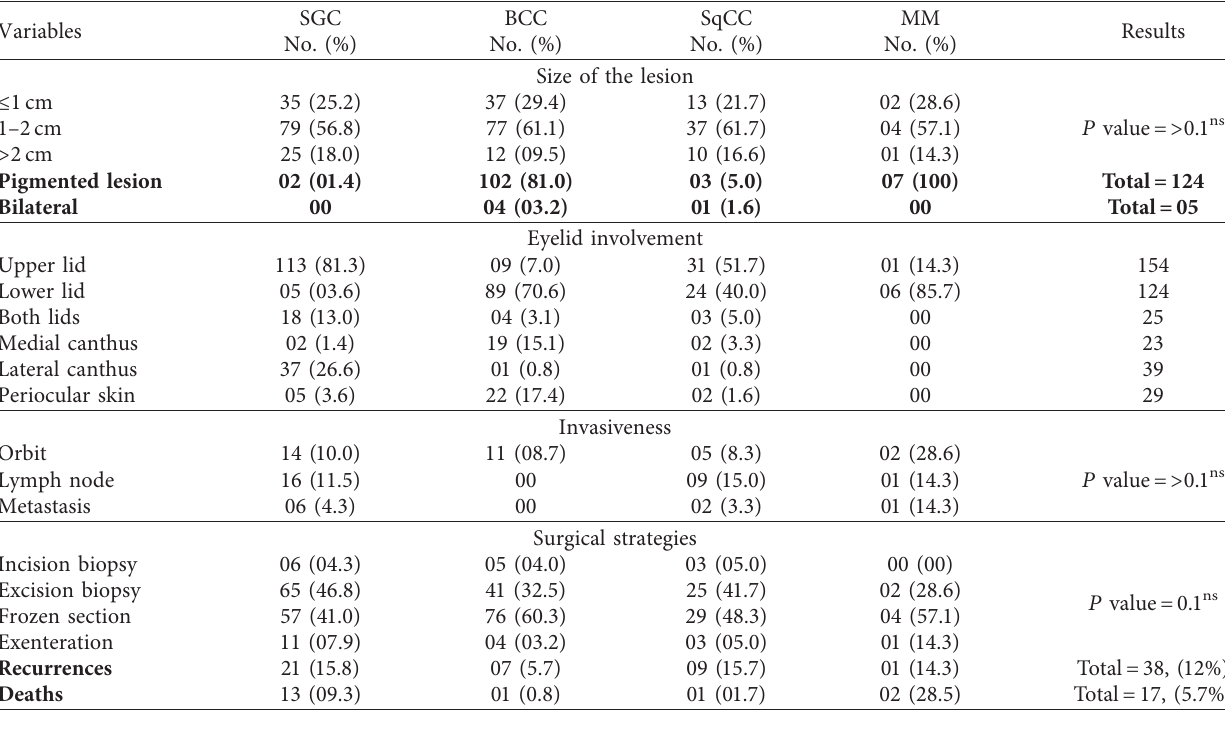
Figure 2: Different types of locally invasive eyelid malignancies: (a) BCC, (b) SqCC, (c) SGC, and (d) melanoma. Table 1: Distribution of the clinical analysis and surgical outcome of the study subjects.